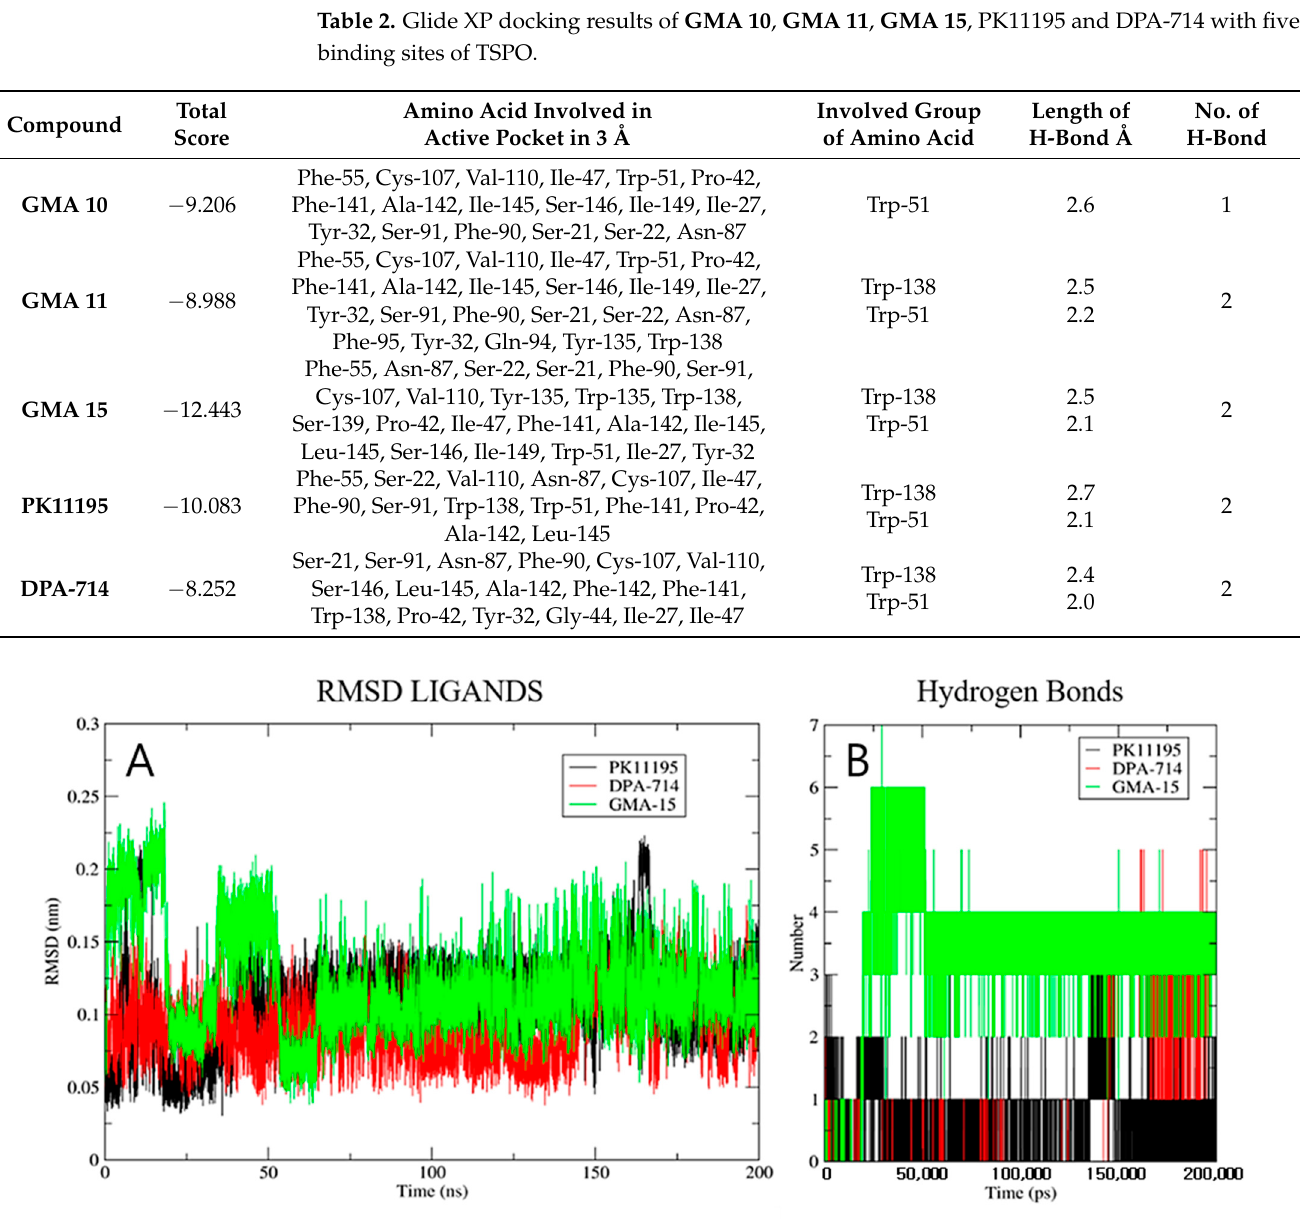
Figure 4. MD simulation results: ( A ) Indicates RMSD plots of the GMA 15 ligand compared to PK11195 and DPA-714. ( B ) Indicates hydrogen bond interactions of GMA 15 compared to PK11195 and DPA-714.